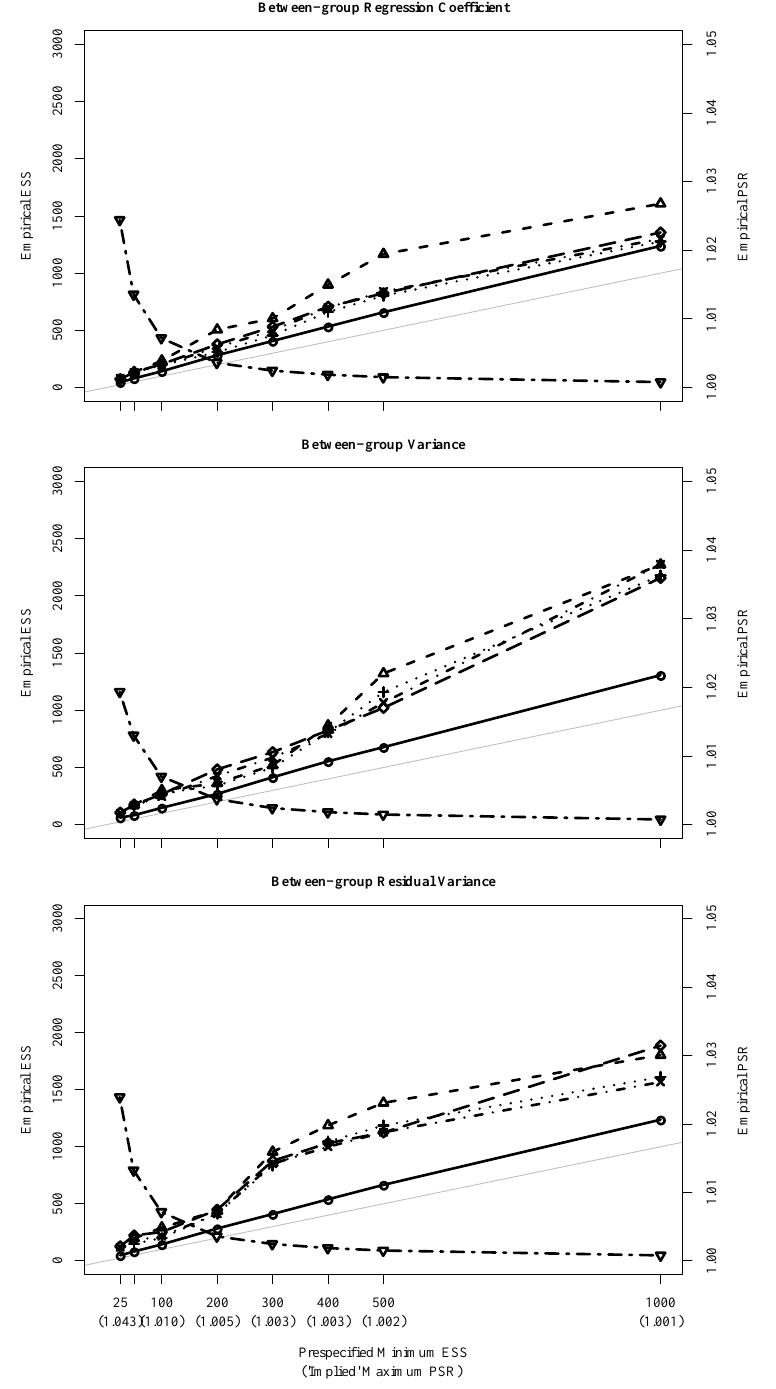
Figure 2. Empirically obtained effective sample size (ESS) and the empirically obtained potential scale reduction (PSR) as a function of the prespecified minimum effective sample size. The grey lines are the bisectors, indicating the identities of the prespecified minimum ESS and the empirical